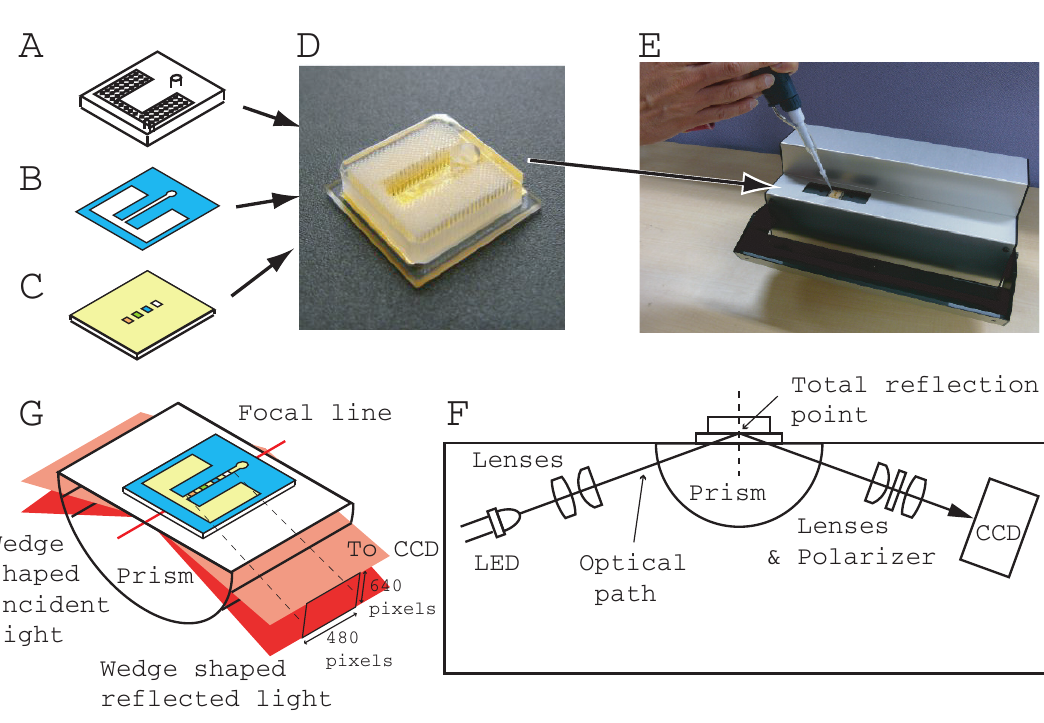
Figure 1. Structure of microfluidic chip for SPR measurement composed of integrated vertical capillary enclosure made of clear acrylic resin ( A ), thin plastic flow channel film ( B ), gold/titanium sputtered substrate with immobilized antibodies and enzyme in band array configuration ( C ), and photograph of finished product ( D ). The chip is mounted on a portable SPR instrument and sample liquid is injected with pipette ( E ). Schematic diagram of the portable SPR instrument, ( F ). Optical configuration at the interface of the instrument and the sensor chip, ( G